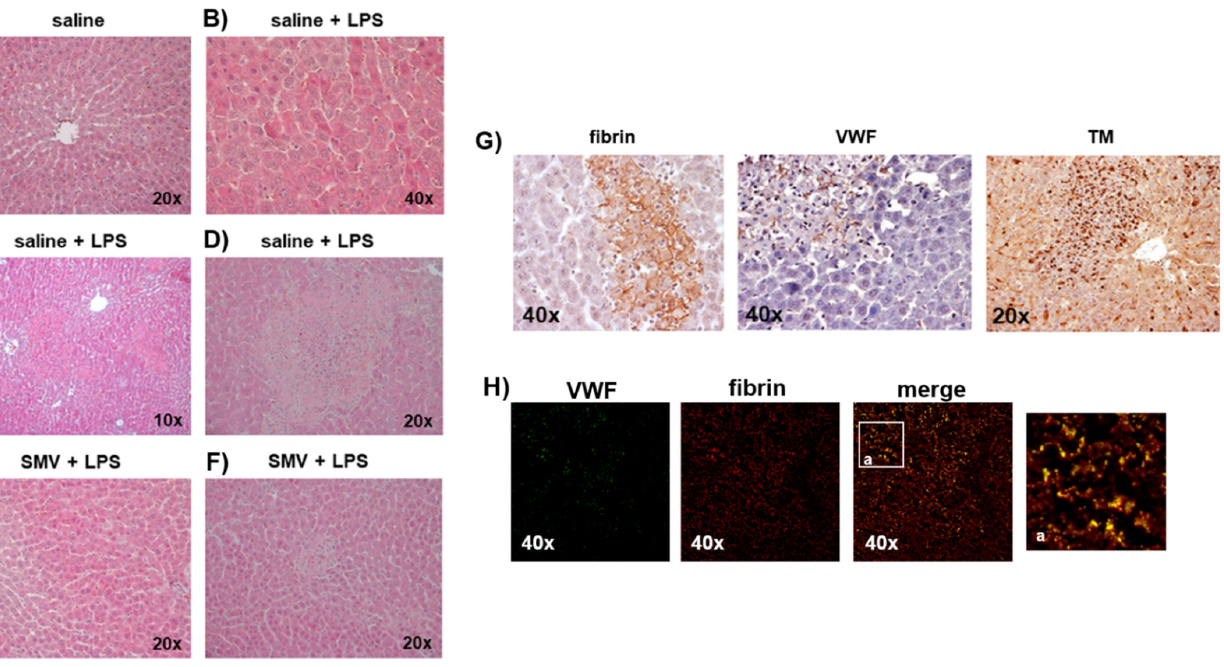
Figure 5. ( A – F ): Liver structure in the different groups of the main experimental protocol (hematoxylin and eosin). All liver samples were collected 24 h after saline vs. LPS-injection (5 mg/kg). ( G , H ): Immunohistochemistry for fibrin, VWF and TM in the liver of rats 24 h after LPS (5 mg/kg). ( A ) In saline rats, we observed a normal structure of the parenchyma. ( B ) In saline + LPS rats, an evident and diffuse eosinophilia was detected ( C , D ), as well as frequent areas of necrosis. ( E ) Simvastatin (SMV) was not able to protect from LPS-induced eosinophilia, ( F ) but liver necrosis was strongly reduced. ( G ) The expression of fibrin, VWF deposition and TM shedding were evident in necrotic areas of the liver parenchyma, suggesting their involvement in the liver injury induced by sinusoidal microthrombosis after LPS. ( H ) Immunofluorescence analysis of a clot from peripheral blood sample showing fibrin and VWF expression and co-localization (last image on the right side represents magnification of co-localization). Micrographs were obtained using a WD THUNDER Imager Tissue 3D. Green: VWF; red: fibrin.